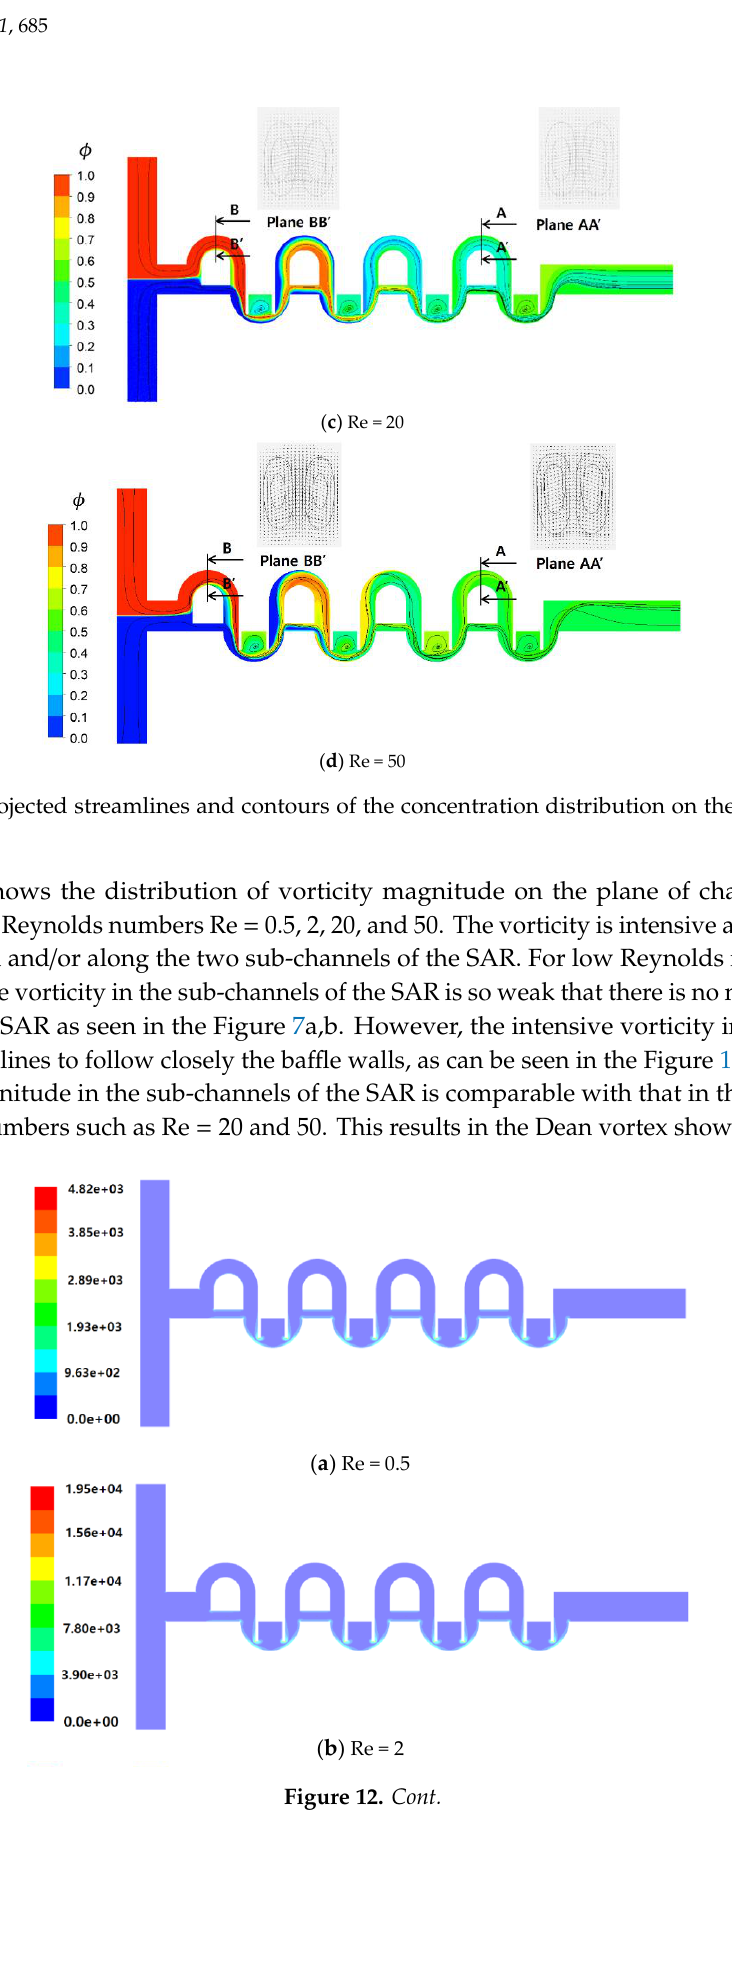
( c ) Re = 20 ( d ) Re = 50 Figure 12. Distribution of vorticity magnitude on the plane of the channel half width z = 60  m. 6. Conclusions A new passive micro-mixer was designed combining SARs with mixing cells, and two baffles were embedded in each mixing cell. Each SAR has two sub-channels: circular and straight. The flow through the circular sub-channel is designed to cross the main channel, and meets the flow through the straight sub-channel at a right angle. The mixing performance of the present micro-mixer was evaluated numerically by examining the DOM and MEC. The numerical simulation was carried out for Reynolds numbers ranging from 0.3 to 80. A comparison with other micro-mixers based on SARs shows that the present micro-mixer performs better over the whole range of Reynolds numbers. Therefore, the mixing enhancement is obtained in the flow regime of molecular diffusion dominance as well as the convection-dominant